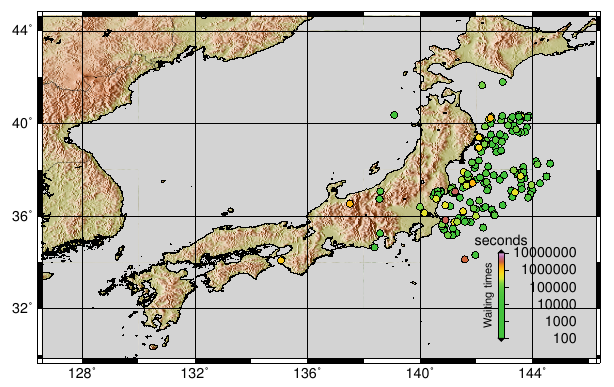
Figure 5. Runup data measured by Mori et al. (2011). Color bar in meters. Different scales present in runup data clearly evident from populations present in figure spanning at least 4 orders of magni-